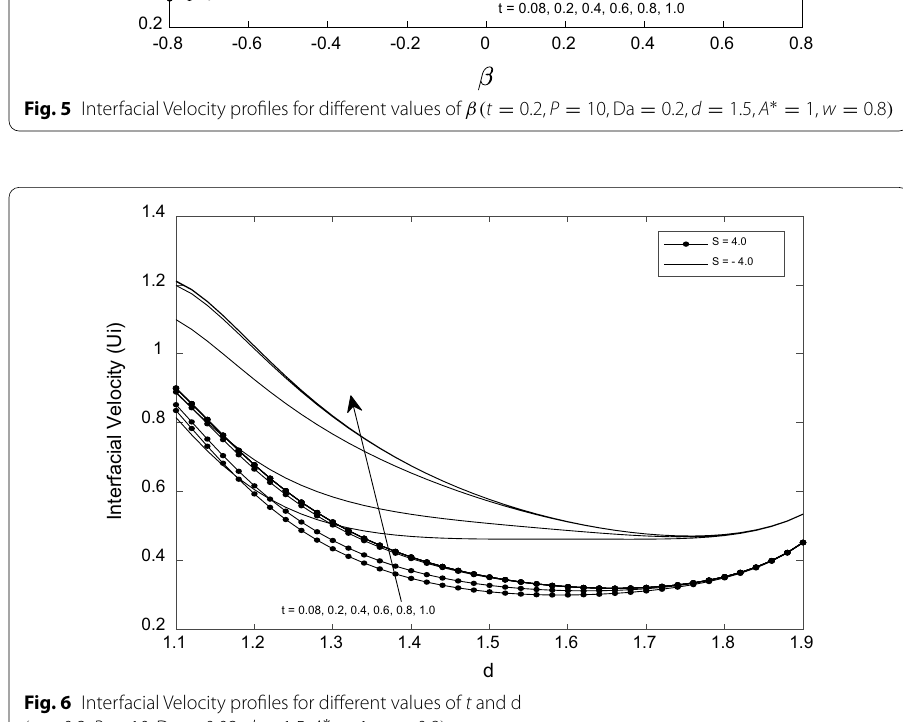
Fig. 6 Interfacial Velocity profiles for different values of t and d 0.2, P 10,Da 0.02, d 1.5, A ∗ 1, w 0.8 ( t = = = = = =